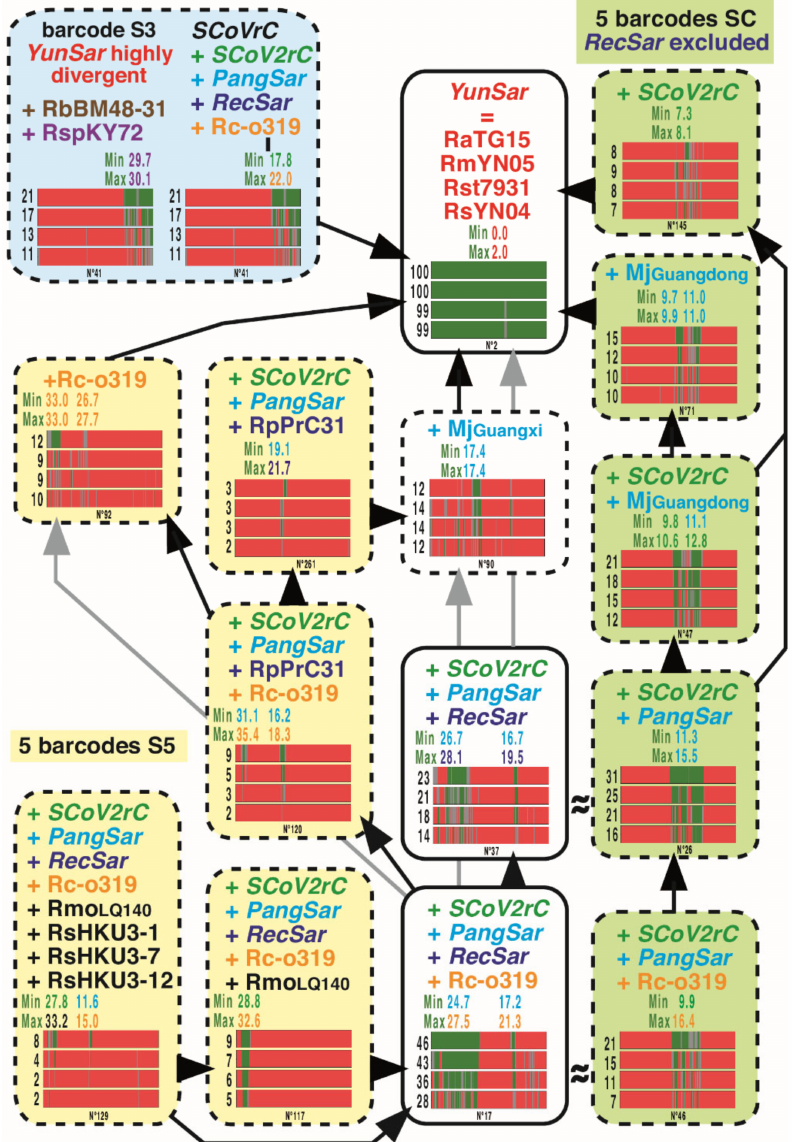
Figure 4. Genomic bootstrap (GB) barcodes generated for the bipartitions including YunSar viruses. For all the 15 bipartitions including the four YunSar viruses, four GB barcodes were constructed from SWB analyses based on the following window sizes: from bottom to top, 250, 500, 1000, and 2000 nt. In GB barcodes, genomic regions in green were supported by bootstrap percentages (BP) ≥ 70%, those in red by BP ≤ 30%, and those in grey by 30% < BP < 70%. For each GB barcode, the value at the left is the mean bootstrap percentage (MBP). The values above GB barcodes are minimum and maximum distances calculated in the genomic region(s) containing robust phylogenetic signal (GRPS) between YunSar and other viruses included in the bipartition. Four categories of GB barcodes were defined based on the genomic location of the phylogenetic support (BP ≥ 70%, green regions): pale yellow for the 5 (cid:48) region; pale olive green for the central region; light blue for the 3 (cid:48) region; and white when the phylogenetic support was distributed in different genomic regions. Only the bipartitions surrounded by a solid black line were found monophyletic in the tree of Figure 3. The bipartitions surrounded by a dashed black line represent hidden phylogenetic signals. As in Figure 3, the colors of sarbecoviruses indicate to which group of synonymous nucleotide composition they belong. The isosceles triangles show nested GB barcodes, the vertex point indicating the nested bipartition, i.e., the one containing fewer viruses. The symbol “ ≈ ” was used to show compatible bipartitions considering the recombinant nature of RecSar